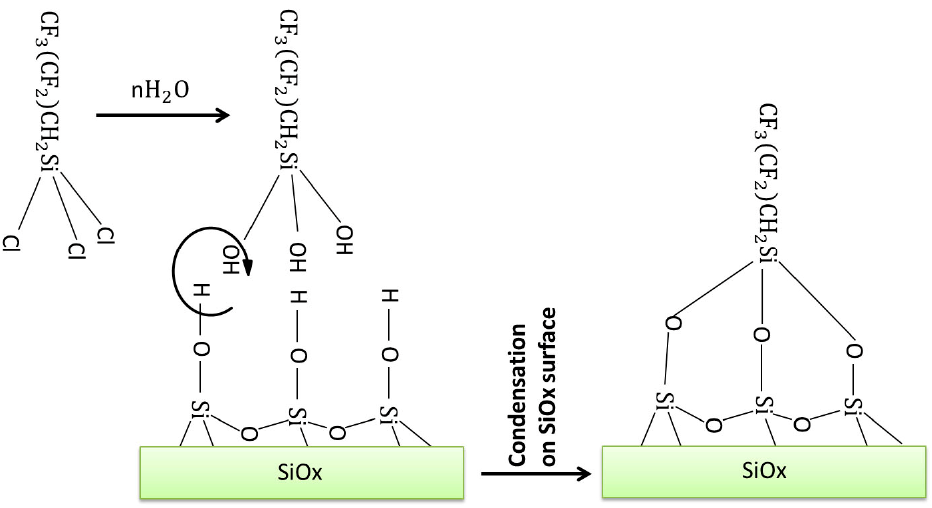
Figure 1. Sketch of the reaction between the 1H,1H,2H,2H-per-fluorodecyltrichlorosilane (FDTS) and the polyethylene terephthalate–silicon oxide substrate (PET-SiOx)